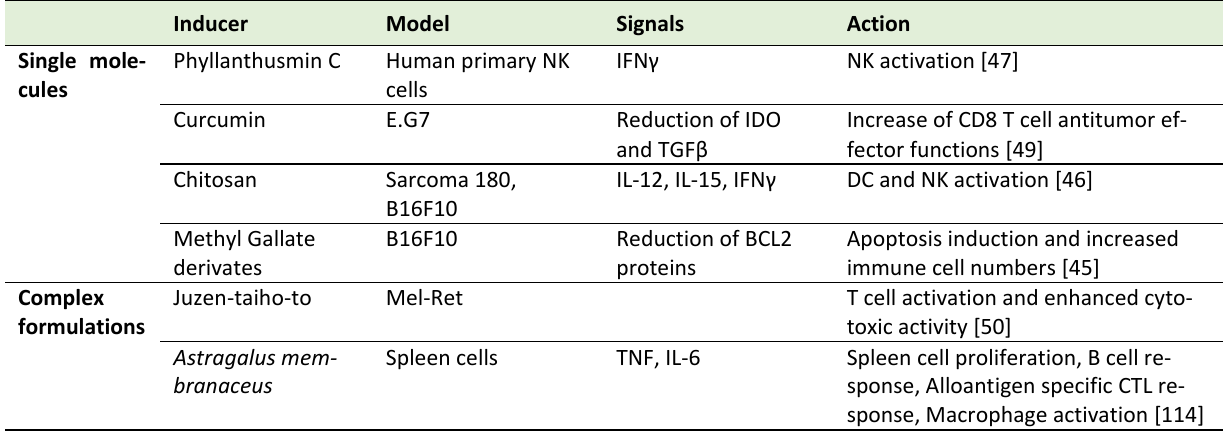
TABLE 3. Other immune system activating natural